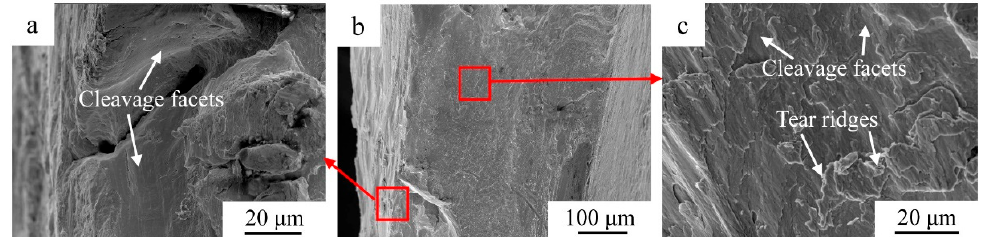
Figure 14. SEM images of the fracture surface of a joint processed without alcohol at 0.55 MPa welding pressure. ( a , c ) the enlarged drawings indicated in ( b ).